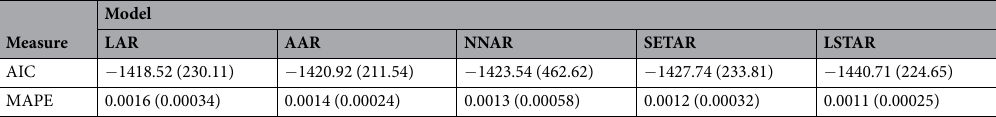
Table 2. Average fitting quality of the five AR models (MAPE – Mean Absolute Percentage Error , AIC – Akaike Information Criterion ). Smaller values of AIC, BIC and MAPE correspond to higher quality models. Values are presented as mean (standard